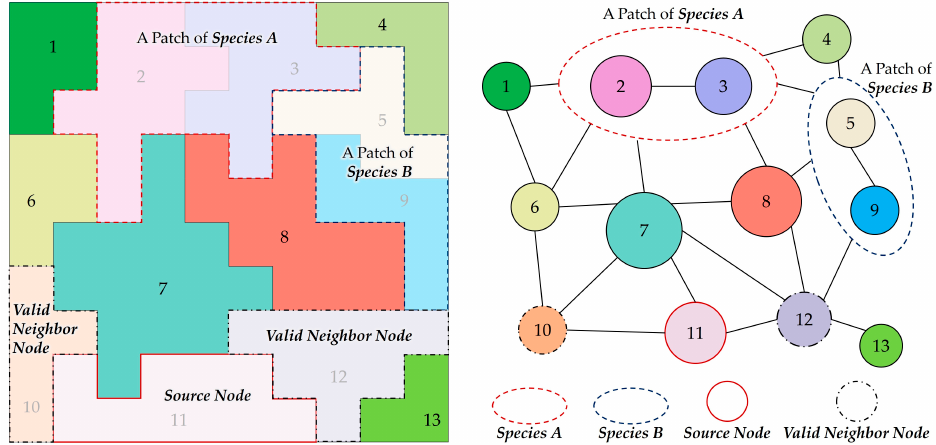
Figure 5. The selection of the source node and of the valid neighbor nodes.